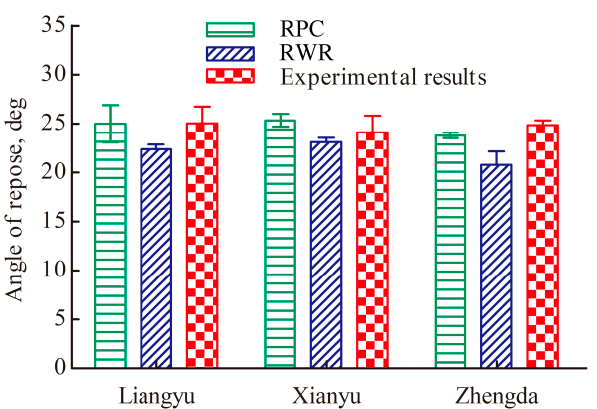
Figure 15. Comparisons between the experimental results and the simulation results in terms of piling angle for three varieties.